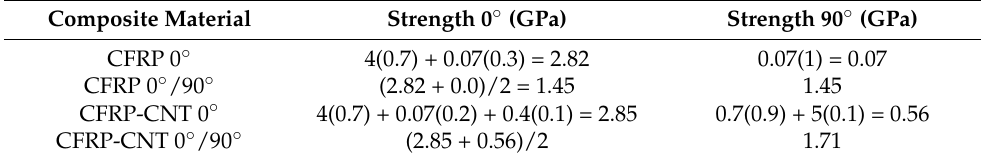
Table 3. Rule of mixtures strength of